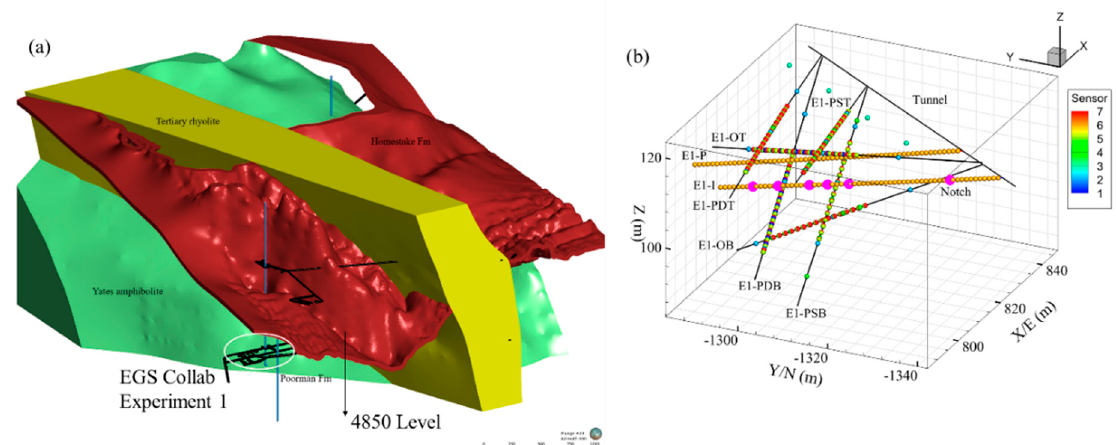
Figure 1. Geological model and layout of holes of EGS Collab Testbed Experiment 1 [2]. ( a ) EGS Collab Testbed Experiment 1 is entirely located within Poorman Formation at 4850 ft depth. ( b ) Six holes (E1-OT/OB, E1-PSB/PST and E1-PDT/PDB) are used as monitoring wells. E1-I and E1-P are injection well and production well, respectively. The six pink spheres along E1-I are notches. The contours represent different types of sensor. For example, Sensor 1 is the 24 hydrophones, Sensor 2 is the 18 accelerometers, Sensor 3 is the 4 geophones, Sensor 4 is the 17 continuous active sources seismic monitoring, Sensor 5 is the 96 thermistors, Sensor 6 is the 123 seismic shot and Sensor 7 is the 96 ERT electrode. Table 1. Reservoir properties used in the model.